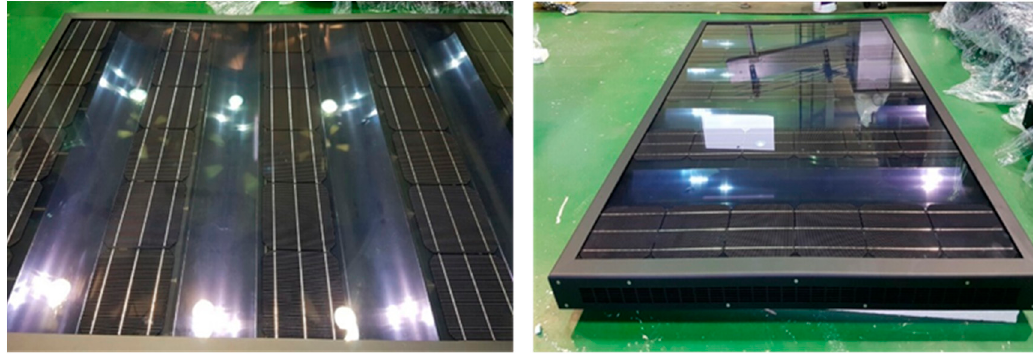
Figure 2. Designed PVT collector. Table 1. PVT module specification.